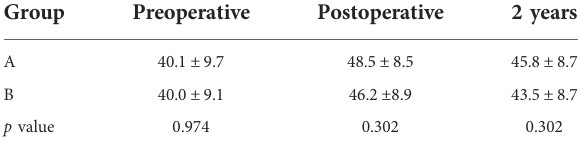
TABLE 6 Lumbar lordotic angle of two groups